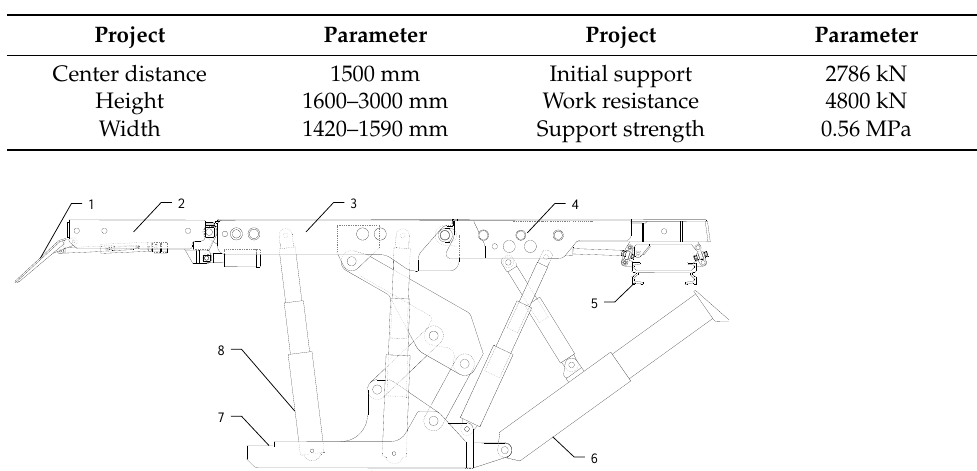
Figure 6. Floor plan of the ZC4800/16/30 backfilling hydraulic support. 1. Guard plate; 2. Front extension beam; 3. Top beam; 4. Rear top beam; 5. Perforated bottom-dump conveyor; 6. Compaction mechanism; 7. Base; 8. Column.